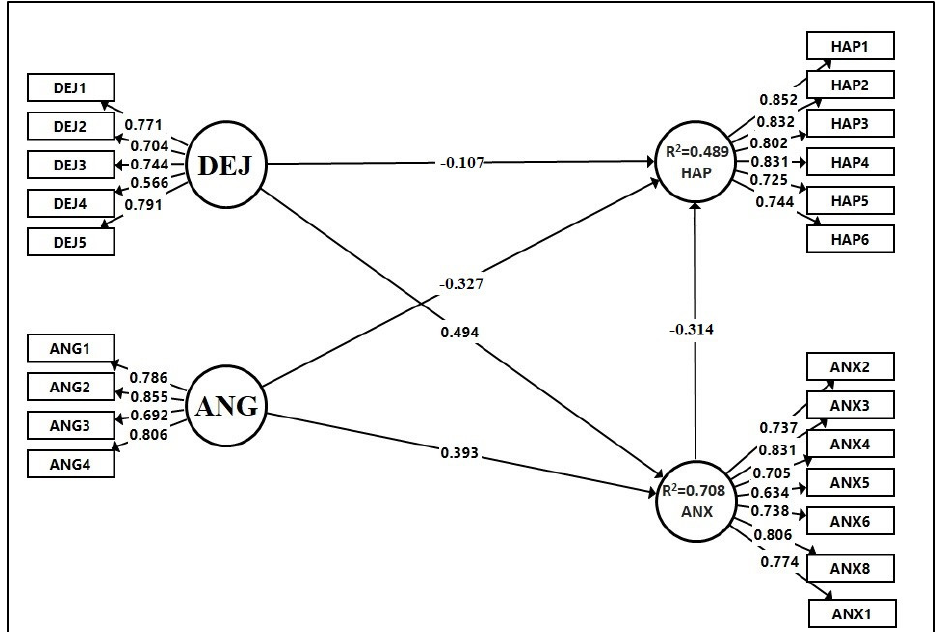
Figure 5. Measurement and structural model results (SmartPLS output).